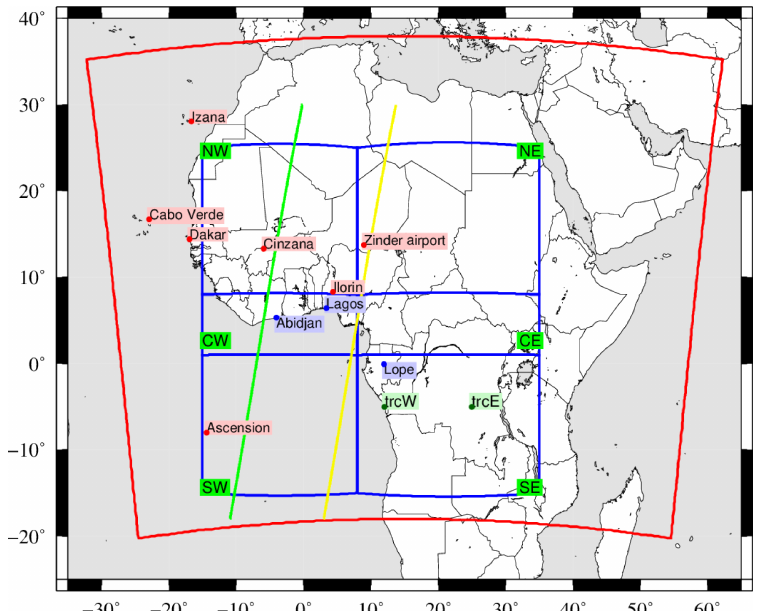
Figure 1. Map of the modelled domain (the red frame). The circles and the location names indicate the stations described in Table 1: the red symbols represent the AERONET stations and the blue symbols represent locations representative of the most studied sites in the DACCIWA project. The two lines represent the CALIOP trajectories, with the green one for 26 July 2014 and the yellow one for 27 July 2014. The sub-domains defined for the comparisons between the model and the IASI data are in